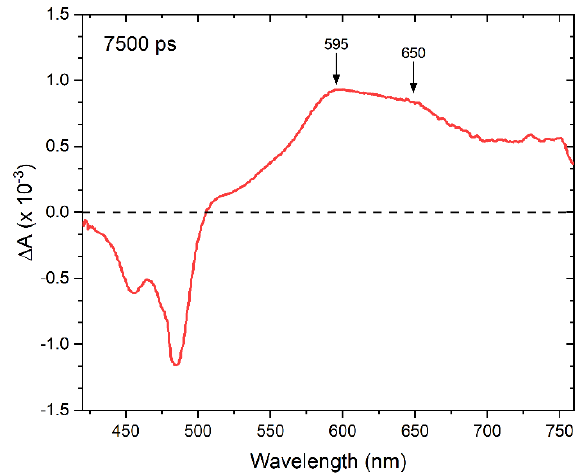
Figure 5. Femtosecond visible transient absorption spectrum of a solution of DNA-templated adjacent dimer obtained at ~7.5 ns.